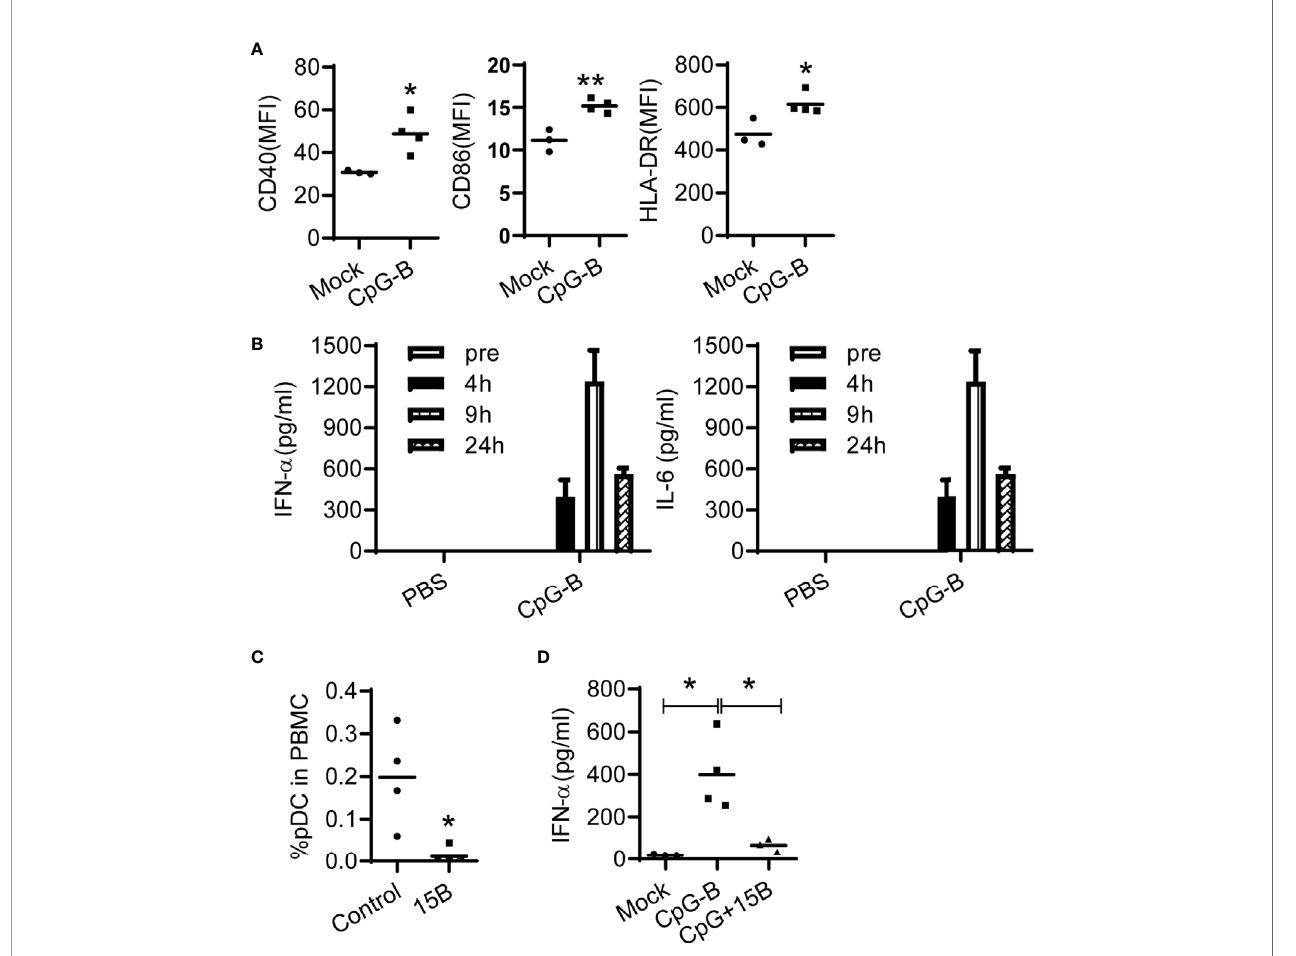
FIGURE 3 | CpG-induced IFN-a production in vivo is dependent on human pDCs in humanized mice. (A, B) Humanized mice were treated with PBS (n=3) or CpG- B (50ug/mouse, i.p., n=4). (A) IFN- a and IL-6 level in plasma at indicated timepoint post treatment were detected by ELISA. (B) The expression of CD40, CD86 and HLA-DR on pDC (CD4 + CD303 + ) from spleens at 24 hours post-treatment was detected by FACS. (C) Humanized mice were pretreated with either isotype control (n=3) or pDC depletion monoclonal antibody (clone 15B, 200 m g/mouse, i.p., n=4) at day -3 and -1. The percentage of pDC in human CD45+ cells from blood were detected by FACS. (D) Humanized mice were pretreated with either isotype control (n=4) or pDC depletion monocolonal antibody (clone 15B, 200 m g/mouse, i.p., n=3) at day -3 and -1. At day0, mice were treated PBS (Mock, n=4) with CpG-B (n=4). IFN-a level in plasma was detected 24 hours after CpG-B treatment. Each dot represents one individual mouse, bars indicate mean. *P < 0.05, **P < 0.01, by unpaired, two-tailed Student ’ s t-test (A, C) or by one-way analysis of variance (ANOVA) and Tukey ’ s multiple comparisons test (D)